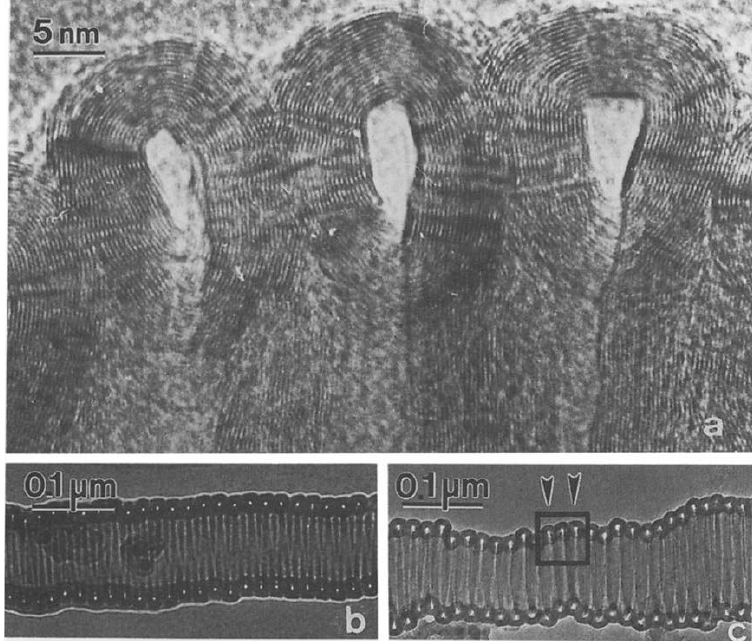
Figure 5. HREM image of a tightly wound helix-shaped carbon nanotubule; insets show two such tubules at lower magnification. Reproduced from [67] with permission.